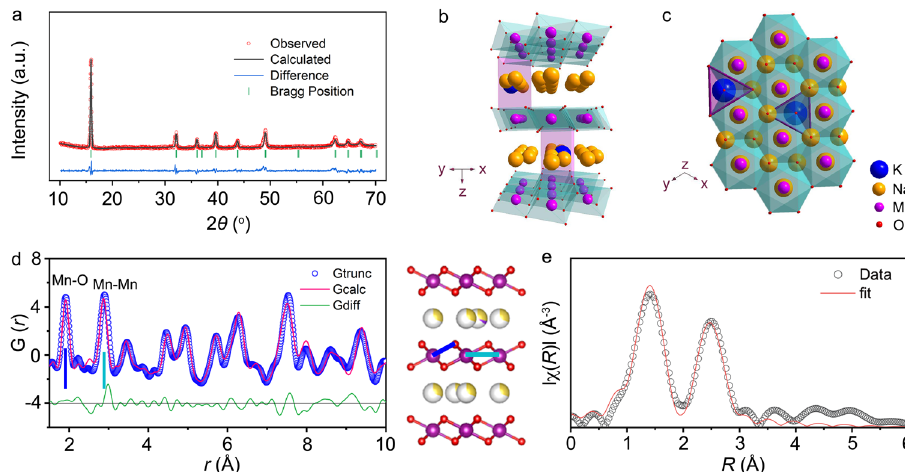
Fig. 1 Crystal structure of Na 0.612 K 0.056 MnO 2 . a XRD pattern and Rietveld re fi nement. Typical layered structure of Na 0.612 K 0.056 MnO 2 viewed along the y axis ( b ) and the z axis ( c ) with K + located at the Na e sites. d PDF pattern and structure of Na 0.612 K 0.056 MnO 2 . The representative peaks correspond to the bond length of Mn – O (blue line) and Mn – Mn (pale blue line) as labeled. e Fitting of Mn K-edge FT-EXAFS spectra of Na 0.612 K 0.056 MnO 2 .